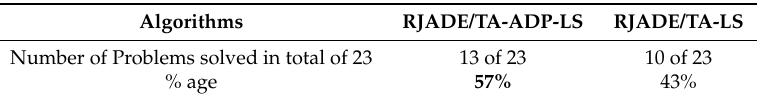
Table 4. Comparing RJADE/TA-ADP-LS with RJADE/TA-LS.